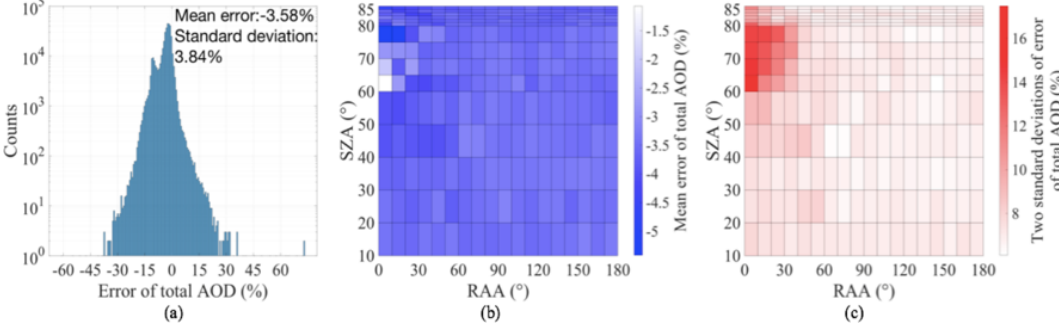
Figure 11. Total AOD retrieval errors: (a) error histogram, (b) mean error as a function of SZA and RAA, and (c) 2 standard deviations as a function of SZA and RAA.